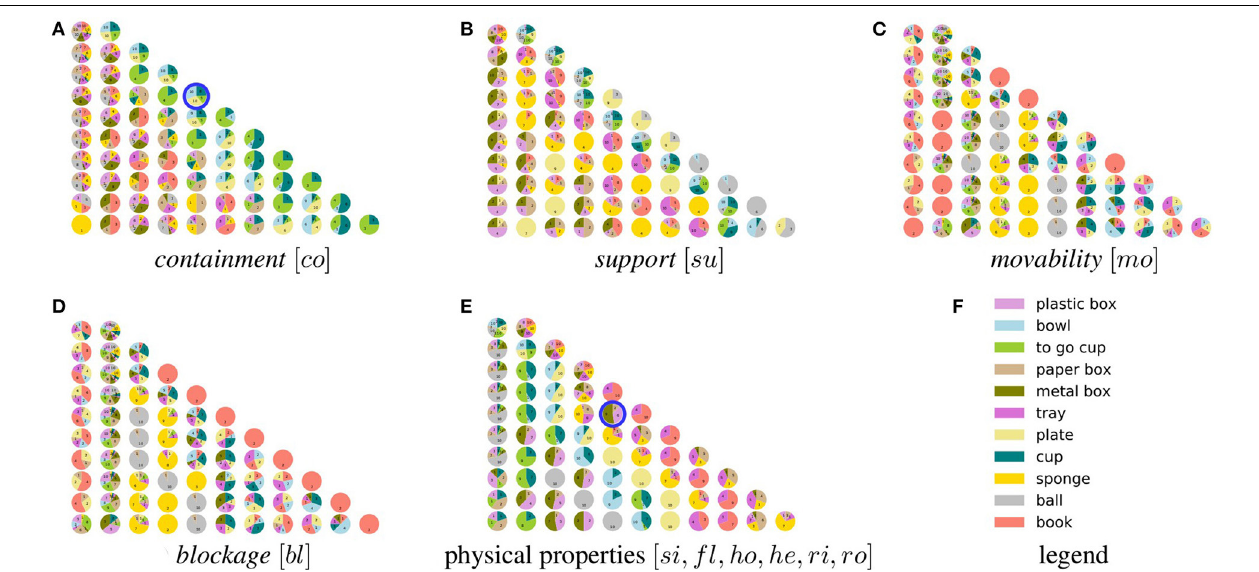
FIGURE 11 | Gradual partitioning of instances to particular concepts given a particular set of properties describing each instance. Each concept is illustrated as a pie chart showing the object class label distribution of instances assigned to the respective concept. Sample concepts are annotated ( ) which illustrate object classes featuring similar quality regarding the property, such as plate , bowl , cup , to_go_cup regarding the containment property. One may observe, that given the assigned classes, object instances are not separable by the generated concepts. This is intended as it enables a quantitative analysis of similarity among instances and across classes based on the